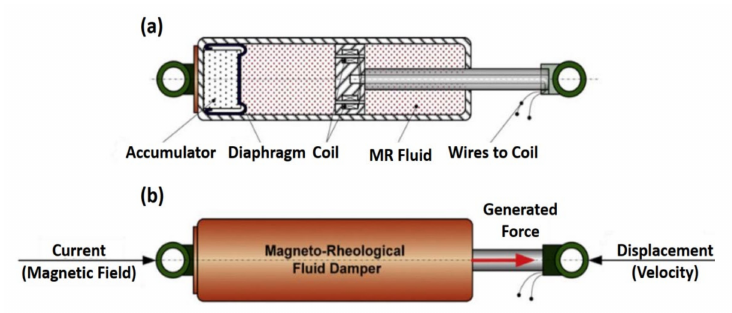
Figure 15. Themagnetorheological(MR)fluiddamper: ( a )Hardwarestructure,( b